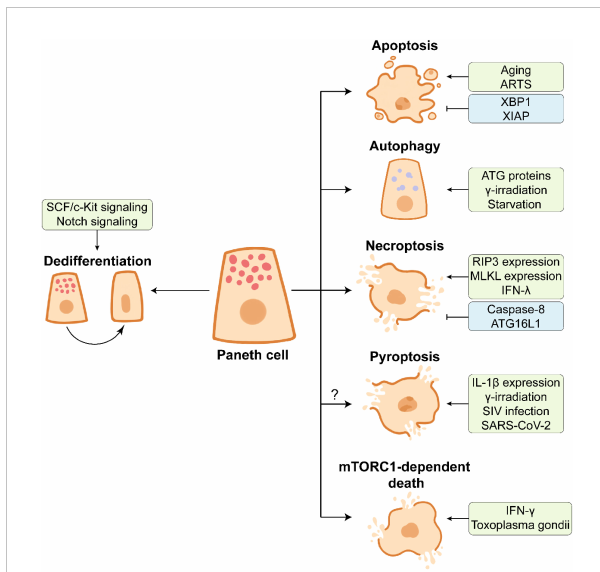
FIGURE 4 The end of Paneth cell life. Paneth cells dedifferentiate into stem- like cells by activating SCF/c-Kit signaling or Notch signaling in response to the intestinal injury, which facilitates intestinal proliferation and repair. Aging or ARTS-expressing Paneth cells undergo apoptosis under the intestinal homeostasis. XBP1 and XIAP have opposite effects on apoptosis of Paneth cells. Paneth cells can remove the damaged organelles and proteins by autophagy, which contributes to the maintenance of cellular homeostasis. ATG proteins, g -irradiation, and starvation are associated with the activation of autophagy in Paneth cells. The necroptosis of Paneth cells is frequently observed in the in fl amed small intestine. The necroptosis of Paneth cells is promoted by highly expressed RIP3 and MLKL and pro-in fl ammatory cytokine IFN- l , and it is inhibited by caspase-8 and ATG16L1. Multiple factors such as high IL-1 b expression in Paneth cells, g -irradiation, SIV infection, and SARS- CoV-2 infection may trigger the pyroptosis of Paneth cells. In Toxoplasma gondii infection, IFN- g induces mTORC1-dependent death of Paneth